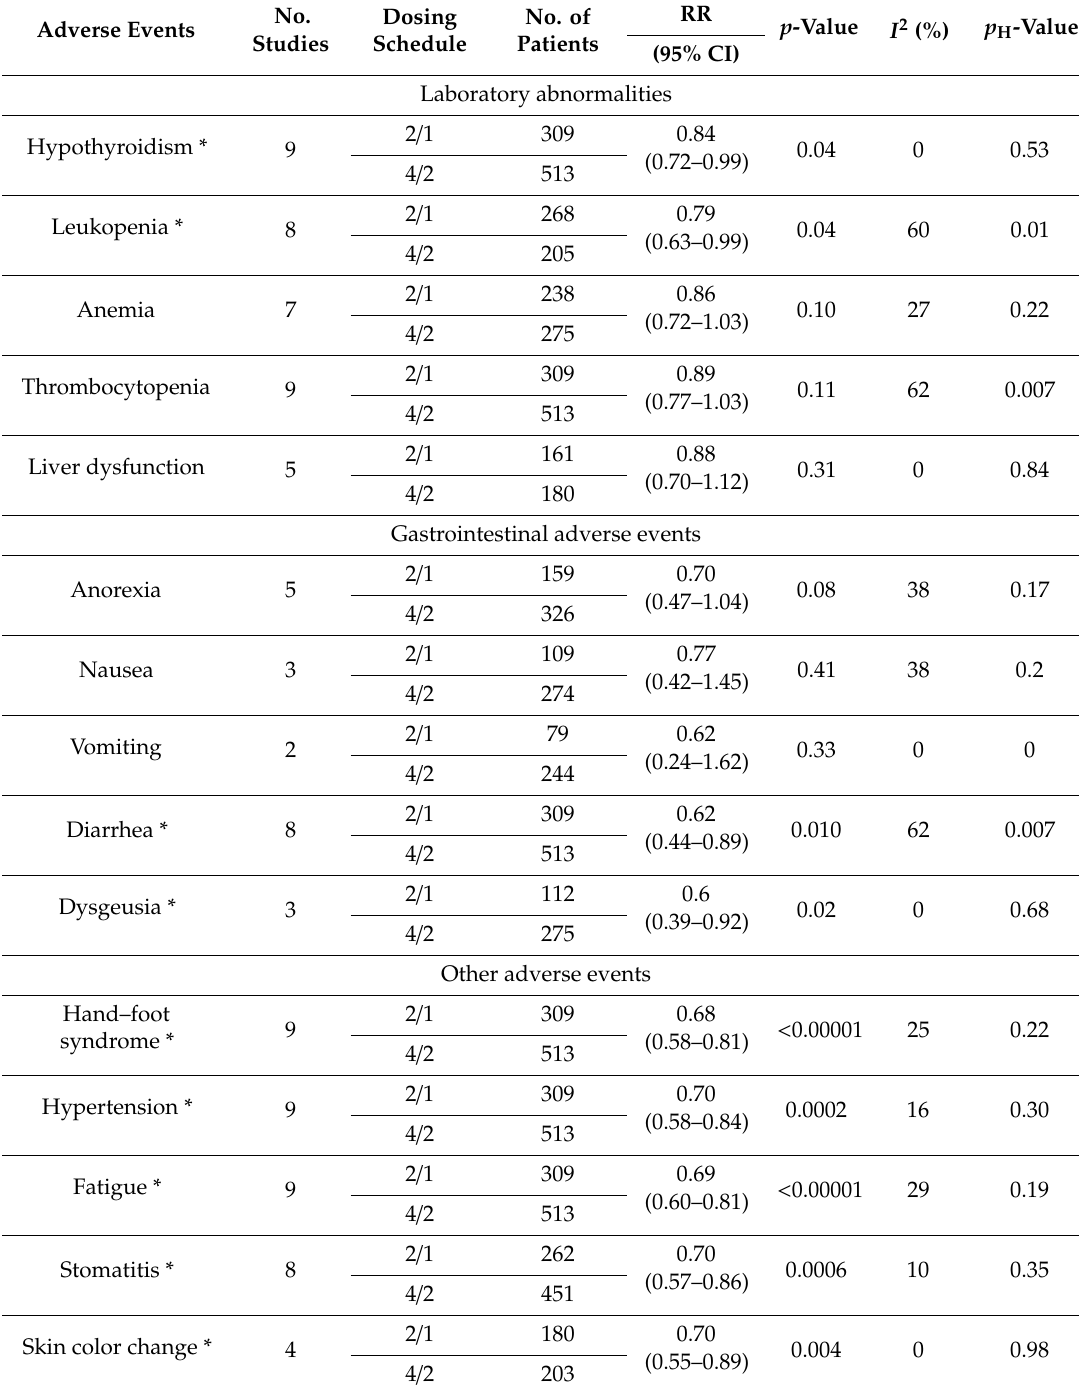
Table 5. Meta-analysis of all grade adverse events according to dosing